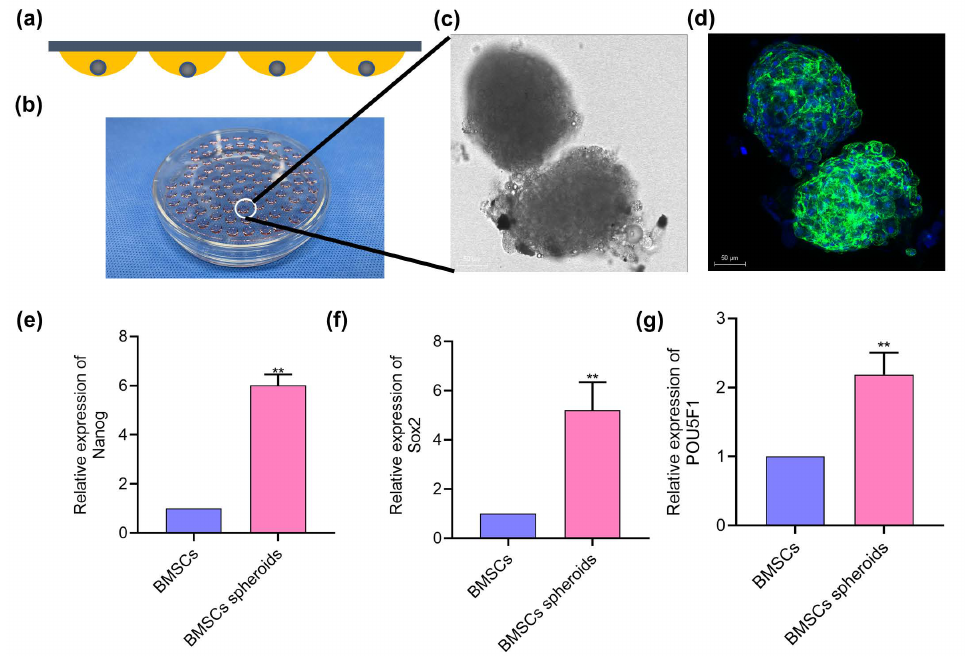
Figure 4. The morphology and stemness-related properties of BMSCs spheroids. ( a ) Schemes of hanging drop method to culture BMSCs spheroids. ( b ) Gross view of the fabrication process of BMSCs spheroids. ( c ) Representative image of BMSCs spheroids. Scale bar = 50 µ m. ( d ) Immunofluorescence image of BMSCs using phalloidin and DAPI staining. Scale bar = 50 µ m. ( e – g ) mRNA expression levels of Nanog, Sox2, and POU5F1 in different cultures of BMSCs. ** p < 0.01, vs. BMSCs group (Student’s t